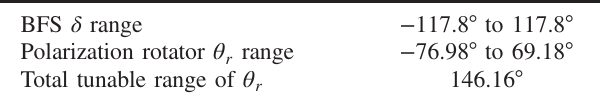
TABLE VII. Measured performance.